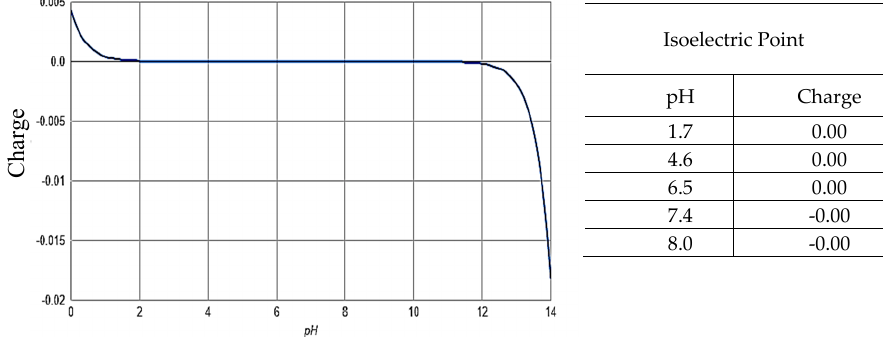
Figure 6. The isoelectric point of urea (calculated using the software MarvinSketch 18.8, ChemAxon, Cambridge, MA, USA).